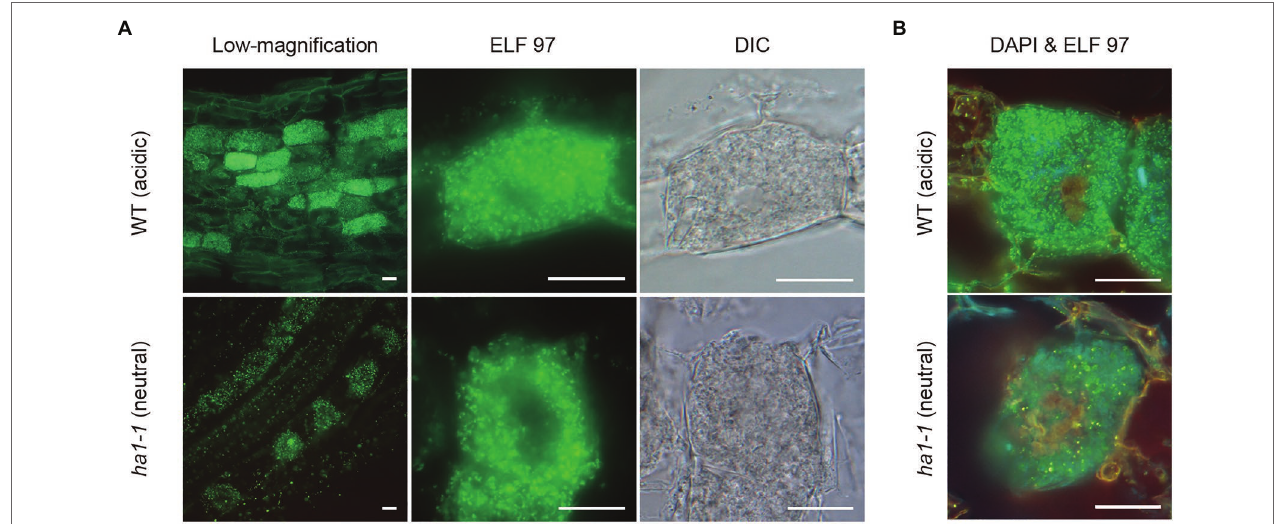
FIGURE 8 | Enzyme cytochemistry of phosphatase activity in arbuscule-containing cortical cells using ELF97. (A) Representative fluorescence images of acid and neutral phosphatase activity in wild-type (WT) and ha1-1 , respectively. Green fluorescence of the ELF97 reaction product indicates phosphatase activity. Arbuscule structure was observed under a DIC microscope. (B) Double labeling using DAPI and ELF97 of WT and ha1-1 under acidic and neutral conditions, respectively. The color balance was adjusted to discriminate between DAPI-polyP complex and the ELF97 reaction product fluorescence. Yellow-orange and green fluorescence indicate polyP and phosphatase activity, respectively. Scale bars = 20 μ